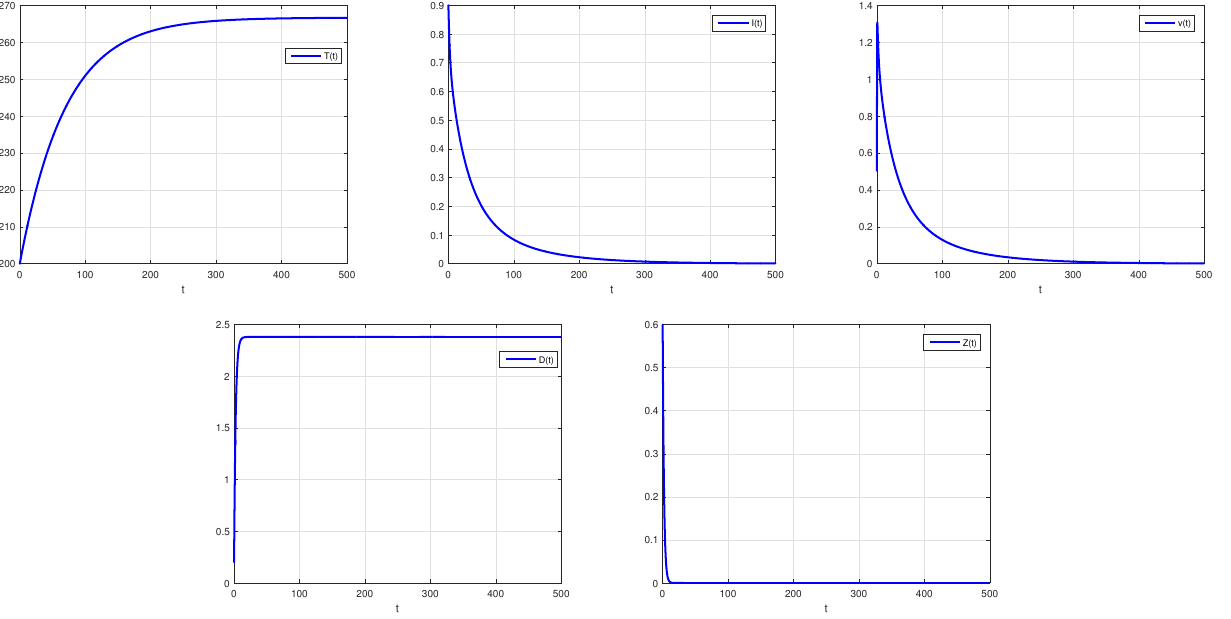
Figure 2. The solution curves of the model (2). Here, the infection-free equilibrium E 0 ≈ ( 266.6666667,0,0,2.380952381,0 ) is globally asymptotically